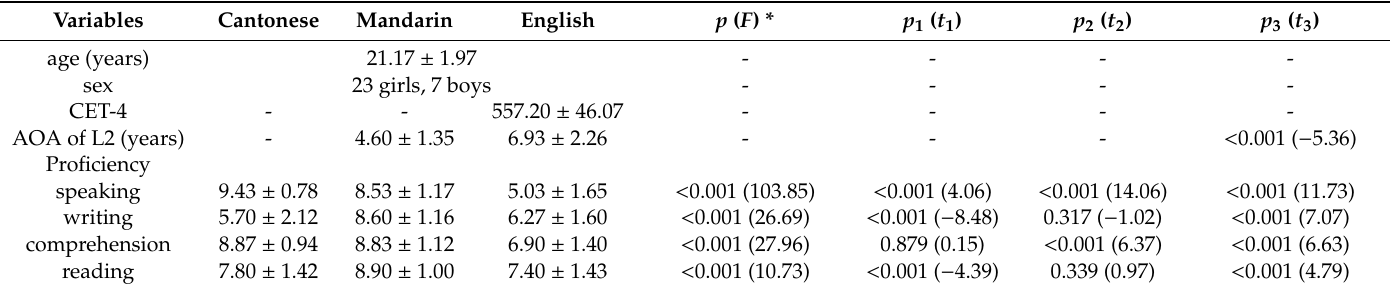
Table 1. Language background of the participants ( n =